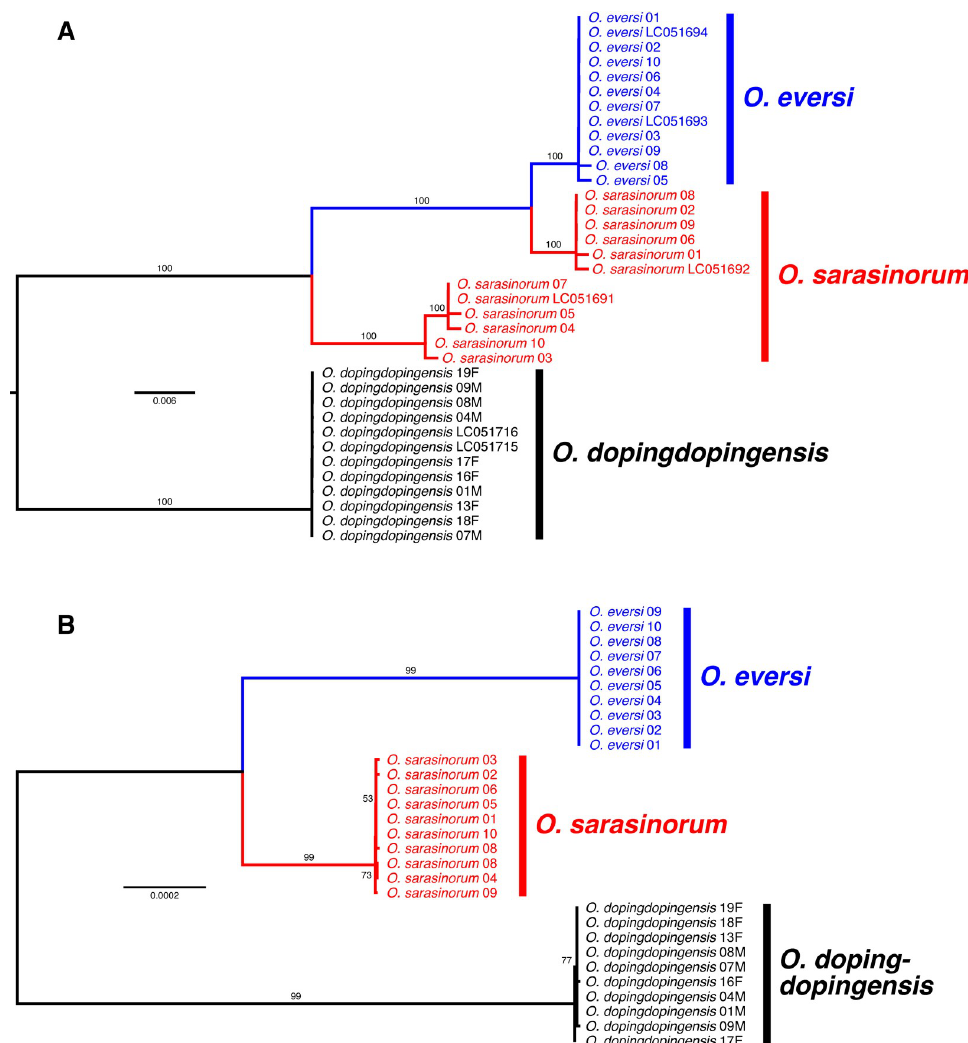
Fig 3. Phylogenies of Oryzias sarasinorum and O . eversi . (A) Maximum-likelihood phylogeny based on the 1,053-bp mitochondrial ND2 sequences and (B) neighbor-joining phylogeny based on the 193,290-bp concatenated RAD sequences. Numbers on branches are bootstrap